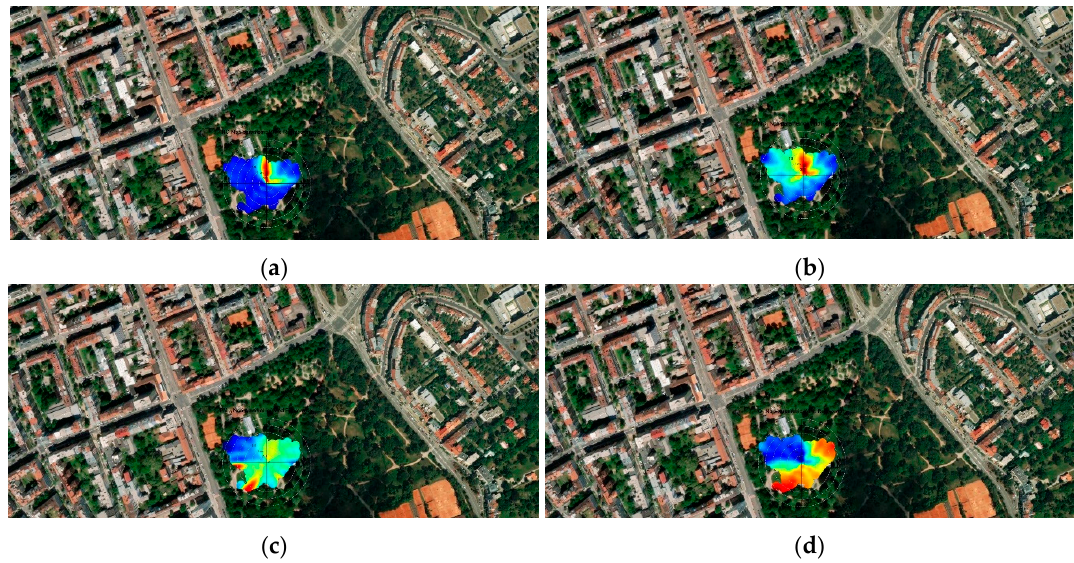
Figure 14. The NO ( a ), NO 2 ( b ), PM 10 ( c ), and O 3 ( d ) concentration relationships to the wind speed and direction at Lužánky SVC; sampling started on 22.8.2019 7:00.